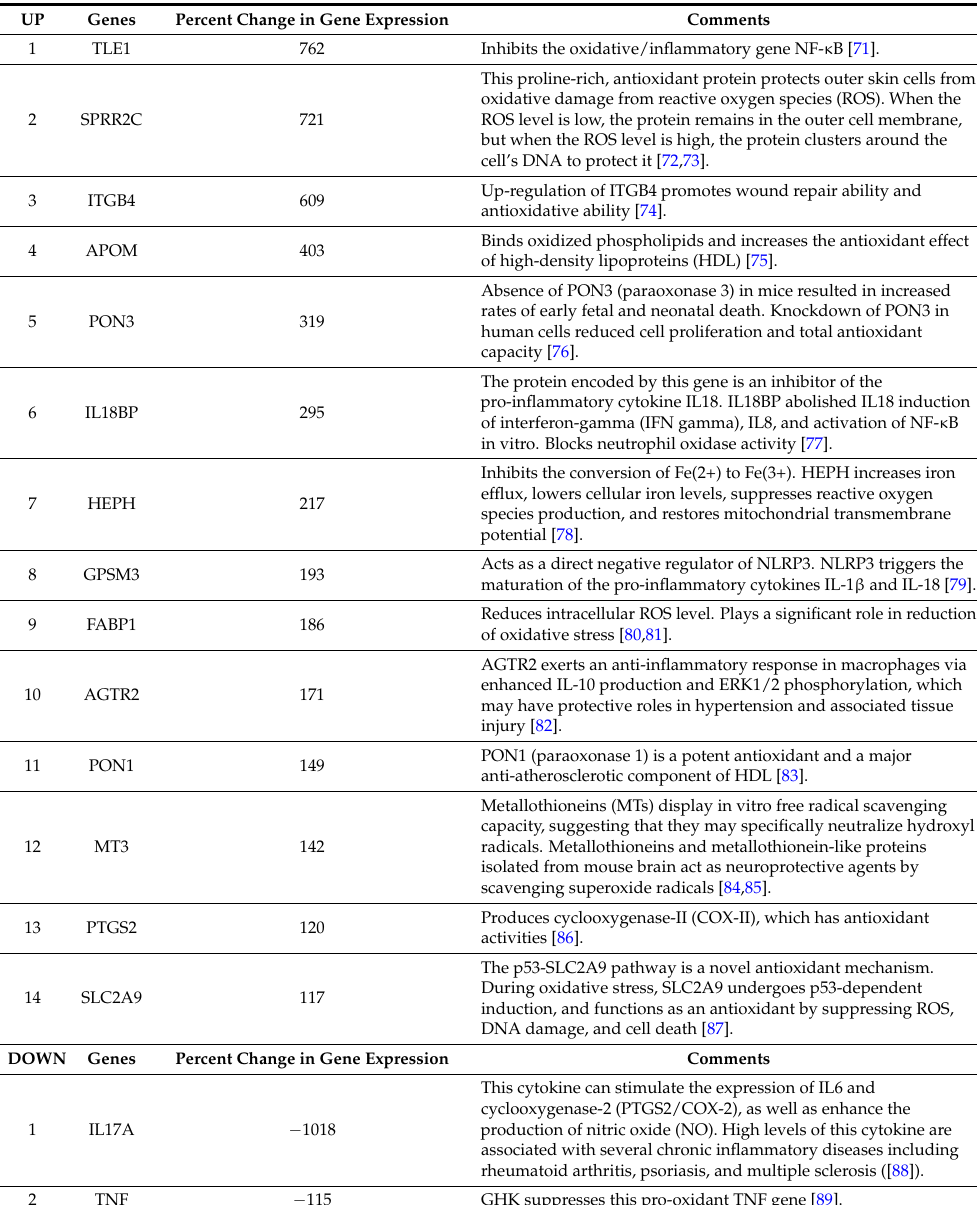
Table 6. GHK and Genes Associate with Antioxidant